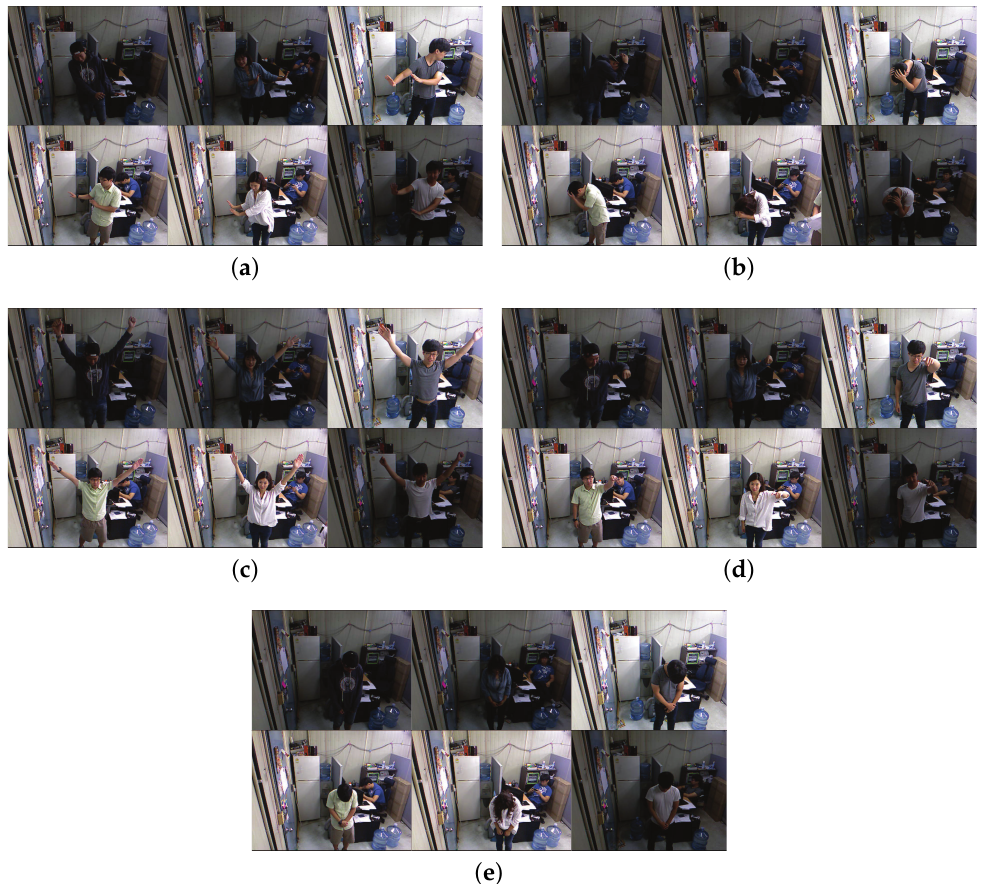
Figure 2. Visual results of all of the emotions. ( a ) Disgust; ( b ) Fearfulness; ( c ) Happiness; ( d ) Hot anger; ( e )